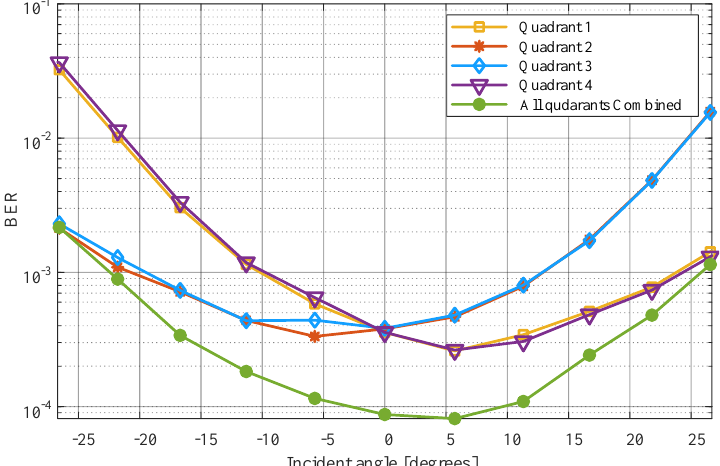
Figure 17. Experimentally measured BERs for each quadrant and for the combined signal using MRC versus the angle of arrival as the transmitter is moved along the x